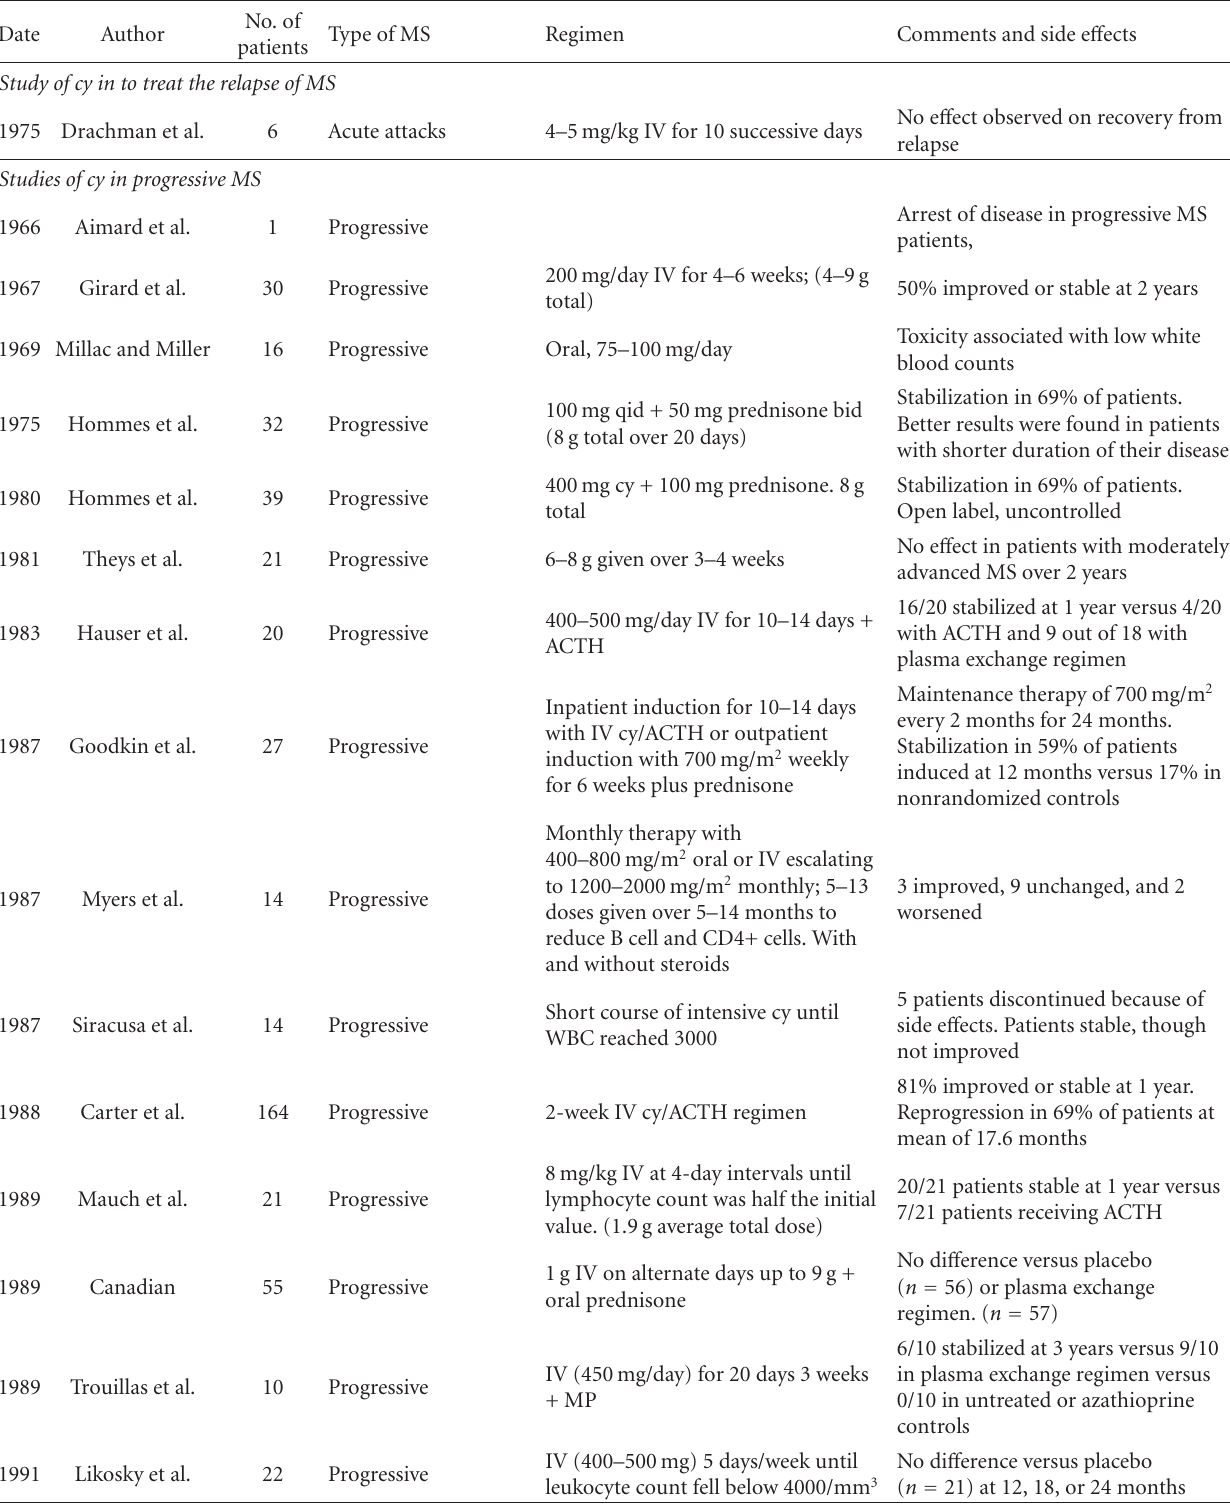
Table 1: Clinical studies of cy in the treatment of